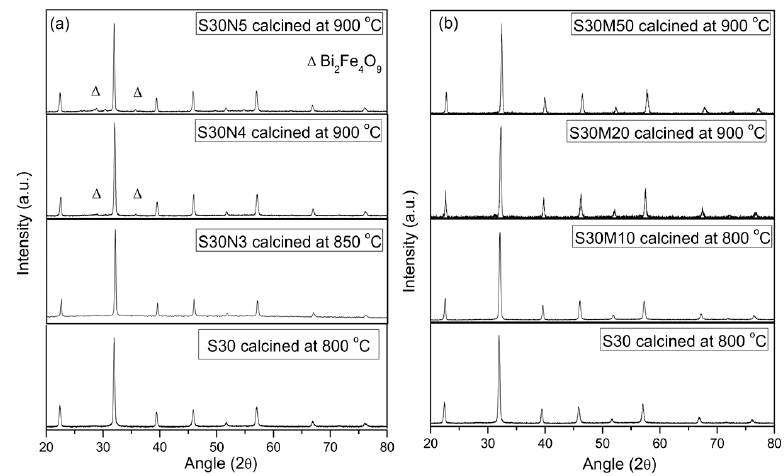
Figure 4. XRD patterns of: ( a ) Bi 0.7 Sr 0.3 Fe 1 − x Ni x O 3 (S30N x ) with the impurity phase Bi 2 Fe 4 O 9 powder (PDF#20-836); and ( b ) Bi 0.7 Sr 0.3 Fe 1 − x Mn x O 3 (S30M x ) calcined at 800 – 900 °C